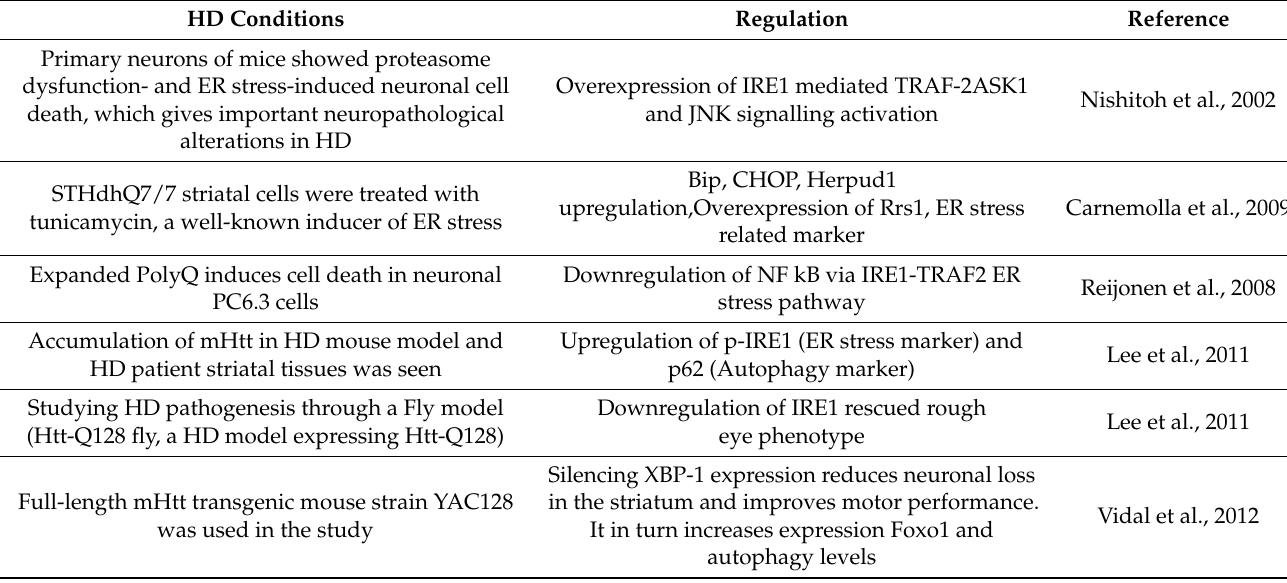
Table 3. Proteins or pathways affected in